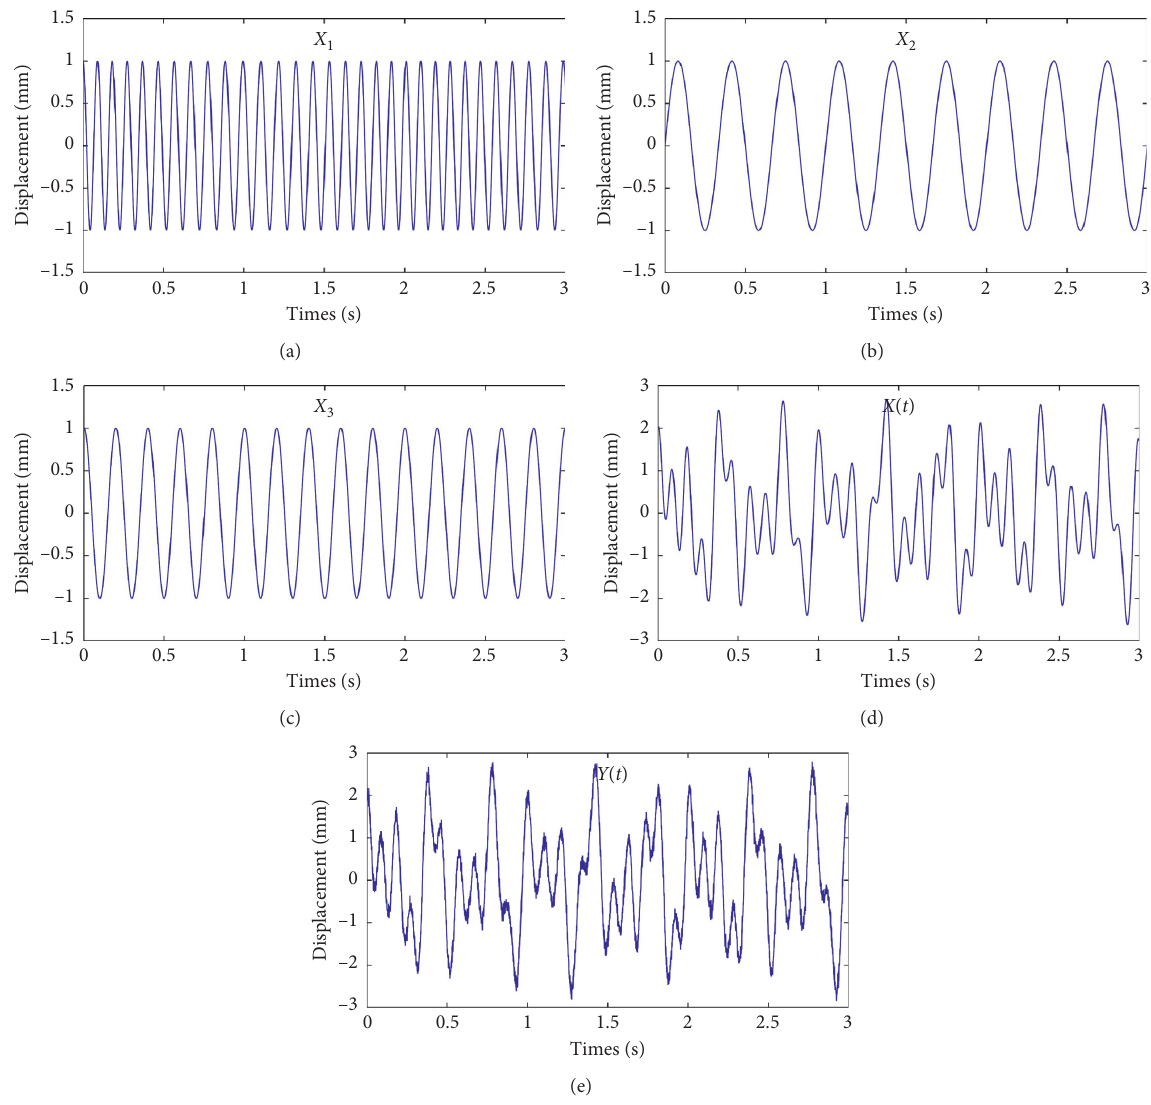
Figure 2: The waveforms of the simulated signal. (a) Waveform of the basic function X (c) waveform of the basic function of X